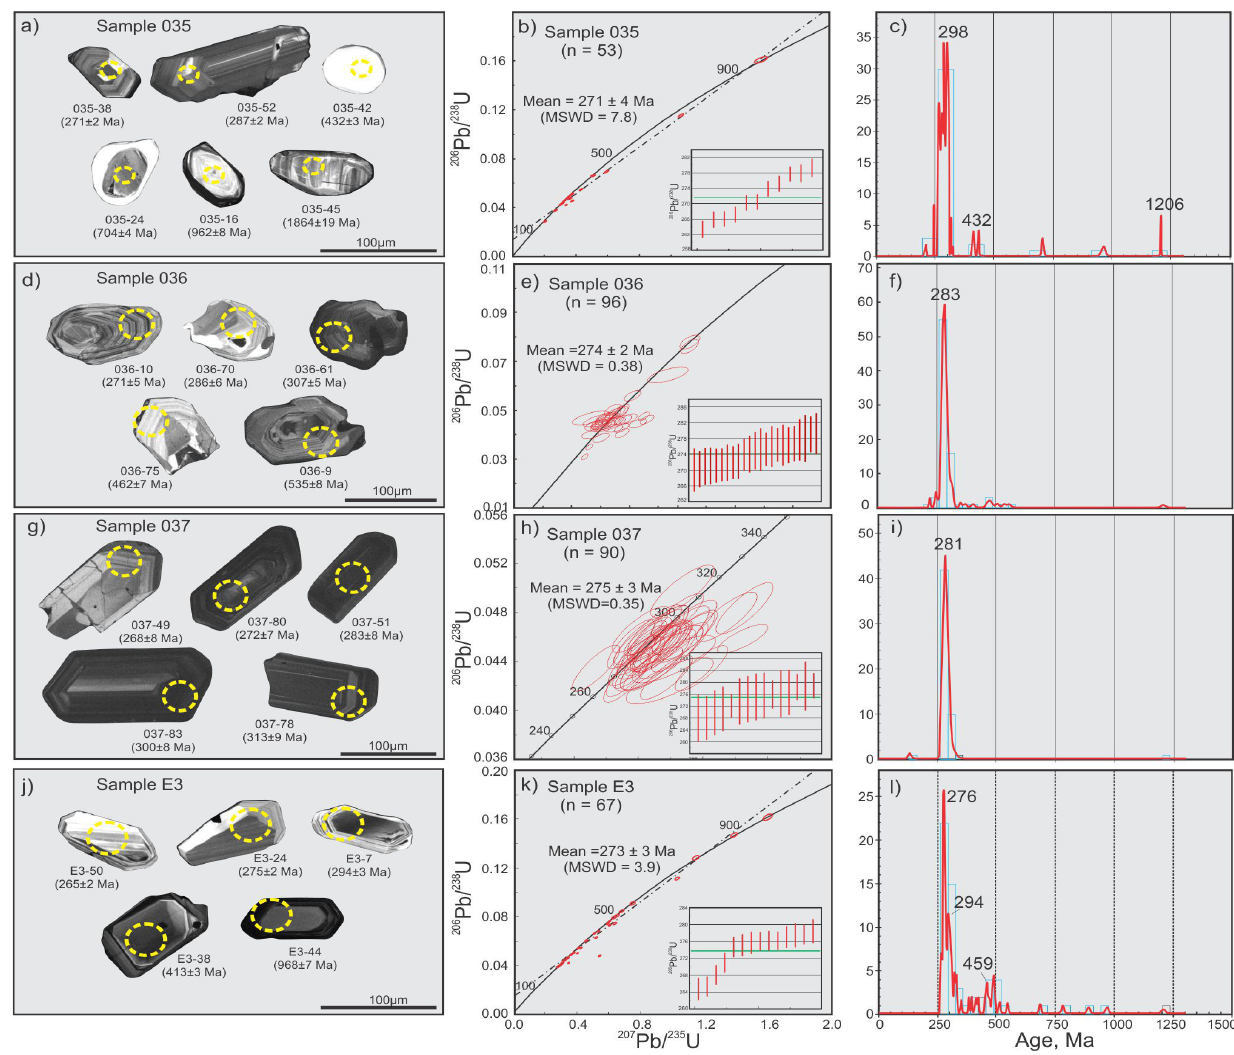
Fig. 7. CL images of typical zircons, zircon 207 Pb/ 235 U - 206 Pb/ 238 U concordia diagrams and age probability histograms of detrital zircons of Sample 035, 036, 037 (Biotite-plagioclase gneiss) from Khaychin Gol area and Sample E3 (Psammitic schist) from Emgentiin Bulag area. The notation for each spot (a, d, g, j) consists of spot number and the 206 Pb/ 238 U age. Inserted small figures are weighted average ages of youngest zircon population of each detrital zircon